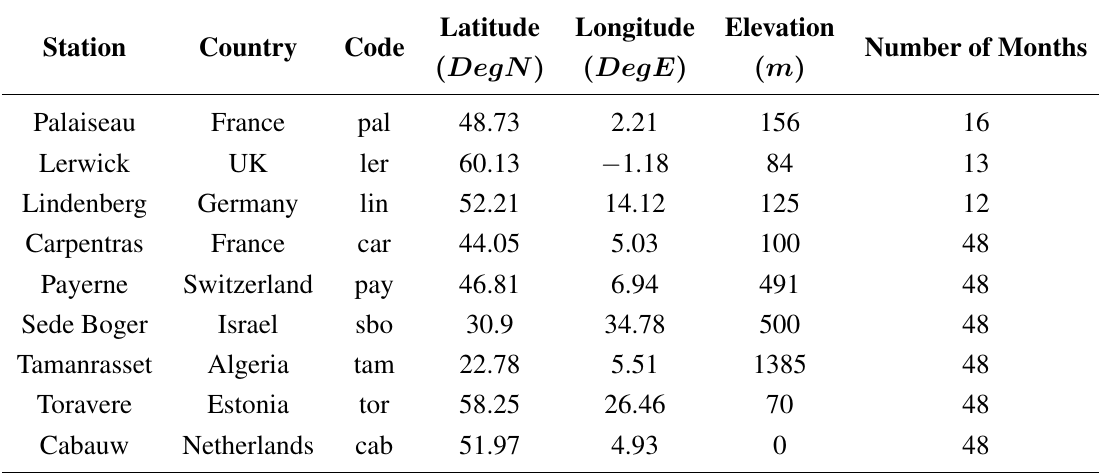
Table 1. List of BSRN stations